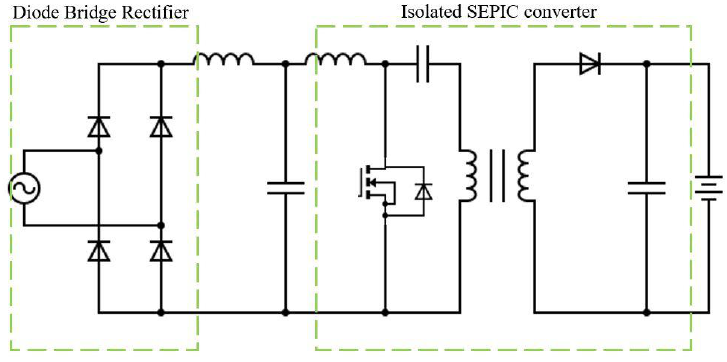
Figure 6. Isolated SEPIC converter with DBR back end [36].